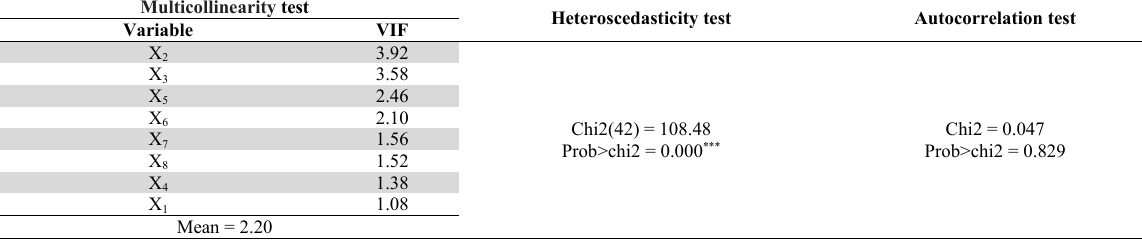
Heteroscedasticity test